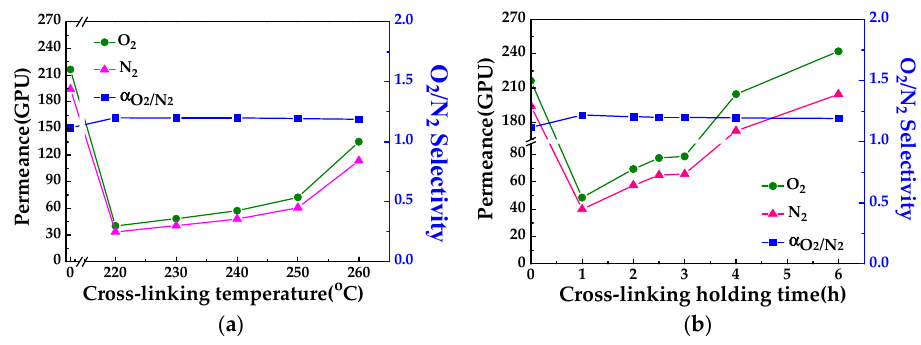
Figure 10. O 2 and N 2 mixed gas permeances of PAN and CLA-PAN membranes prepared at different cross-linking temperatures ( a ) and in different cross-linking holding time ( b ). Table 3. Mixed gas separation performances of PAN membrane and CLA-PAN membranes.